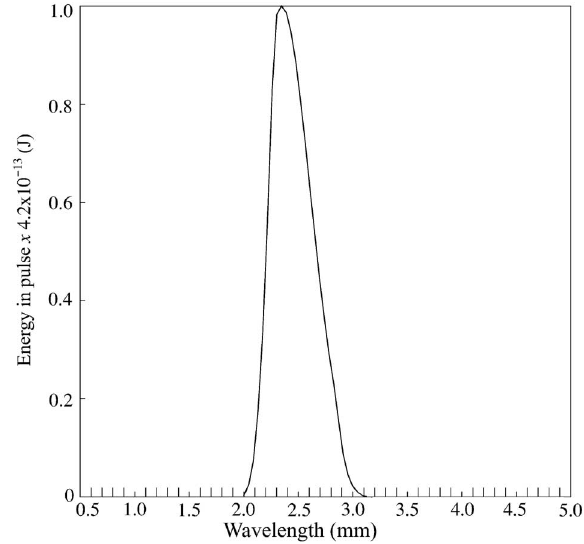
FIG. 3. Calculated energy versus wavelength, with the mirror assembly at 90 ± . The pulse shape is assumed to be triangular with an asymmetry factor e (cid:1) 1.1